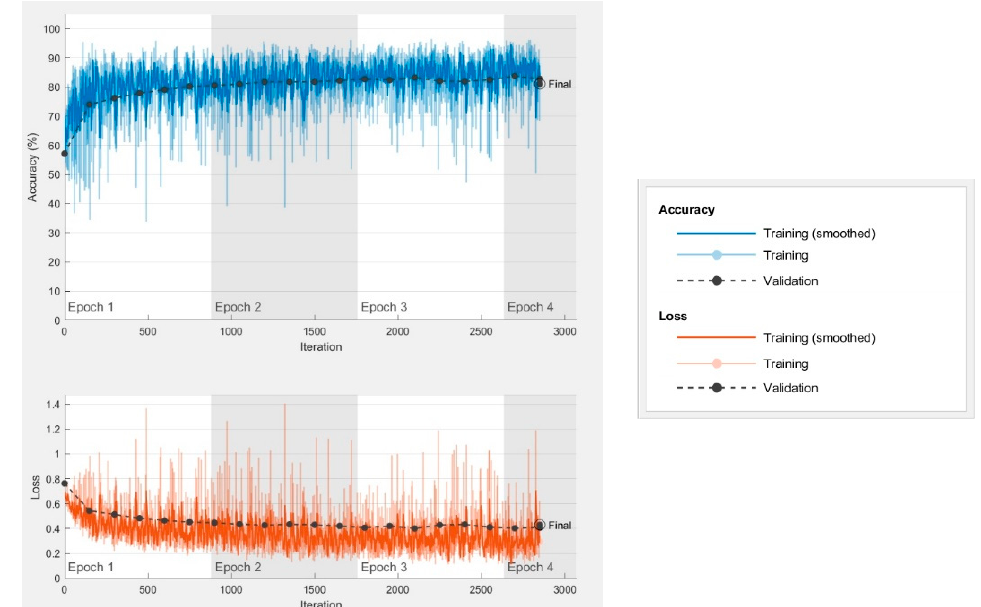
Figure 5. Deep-learning model 13 training